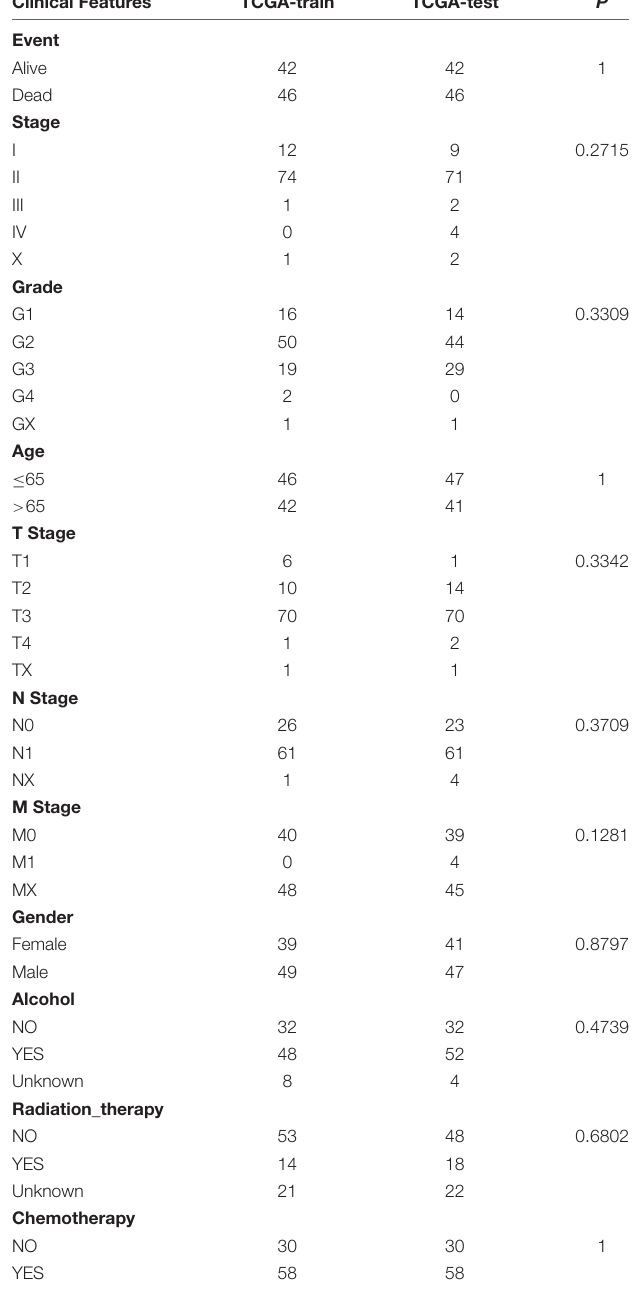
TABLE 1 | Differences in clinical characteristics between training set and validation